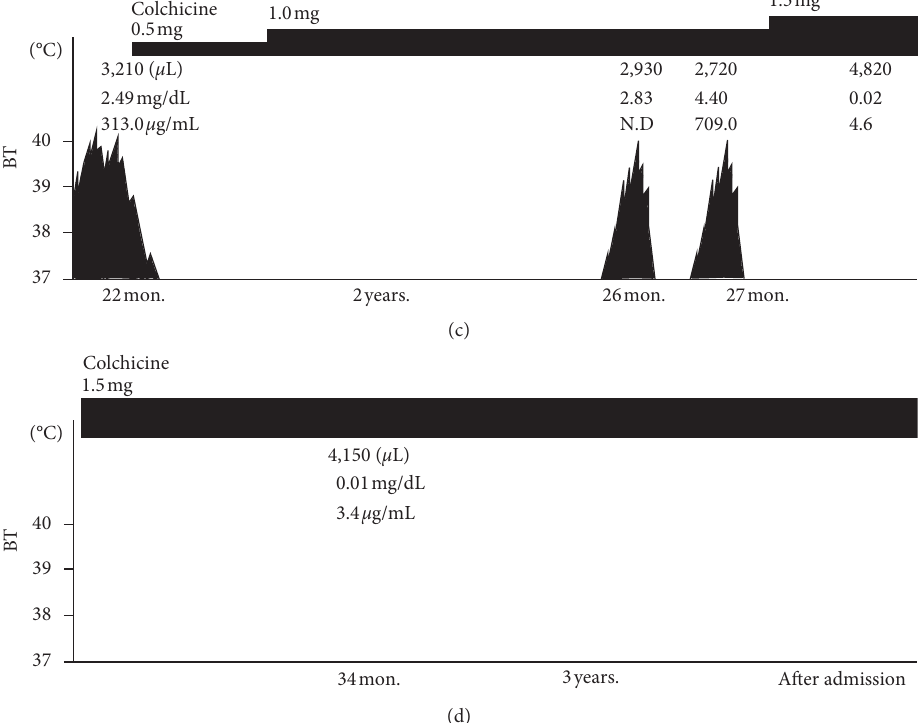
Figure 1: The clinical course. Horizontal axis shows months after the patient’s admission, and vertical axis shows patient’s body temperature (BT, notated Celsius temperature). Jagged black area means the duration and the height of patient’s fever. WBC, white blood cells; CRP, C- reactive protein; SAA, serum amyloid A; N.D, no data. Table 2: Profile of previously reported FMF patients with MEFV p.Ser503Cys exon 5 variants. Febrile attack Other symptoms of FMF Patient (Ref.) Age (yr)/sex MEFV FMF Frequency (mo) Duration (day) Ab. Th. Arth. Head. Response to colchicine